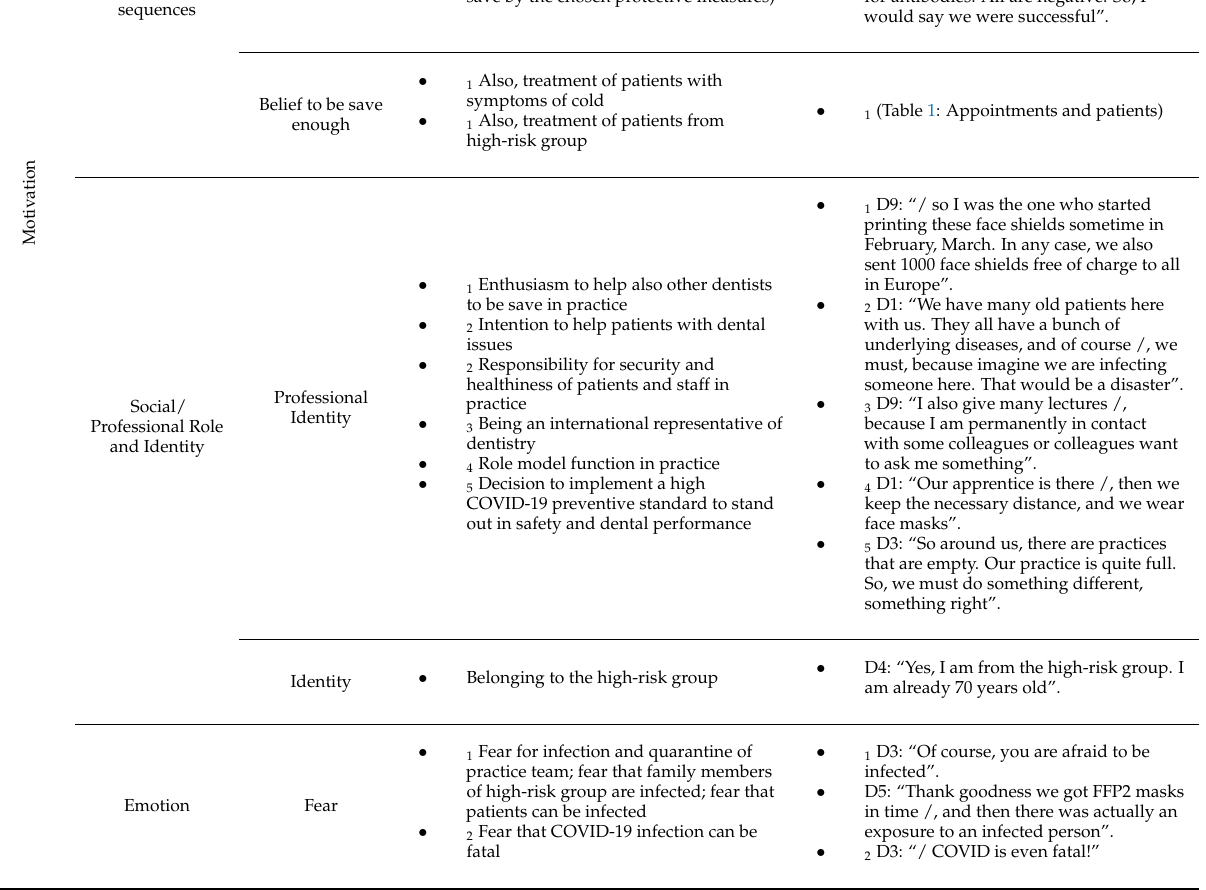
1 (Table 1: Appointments and